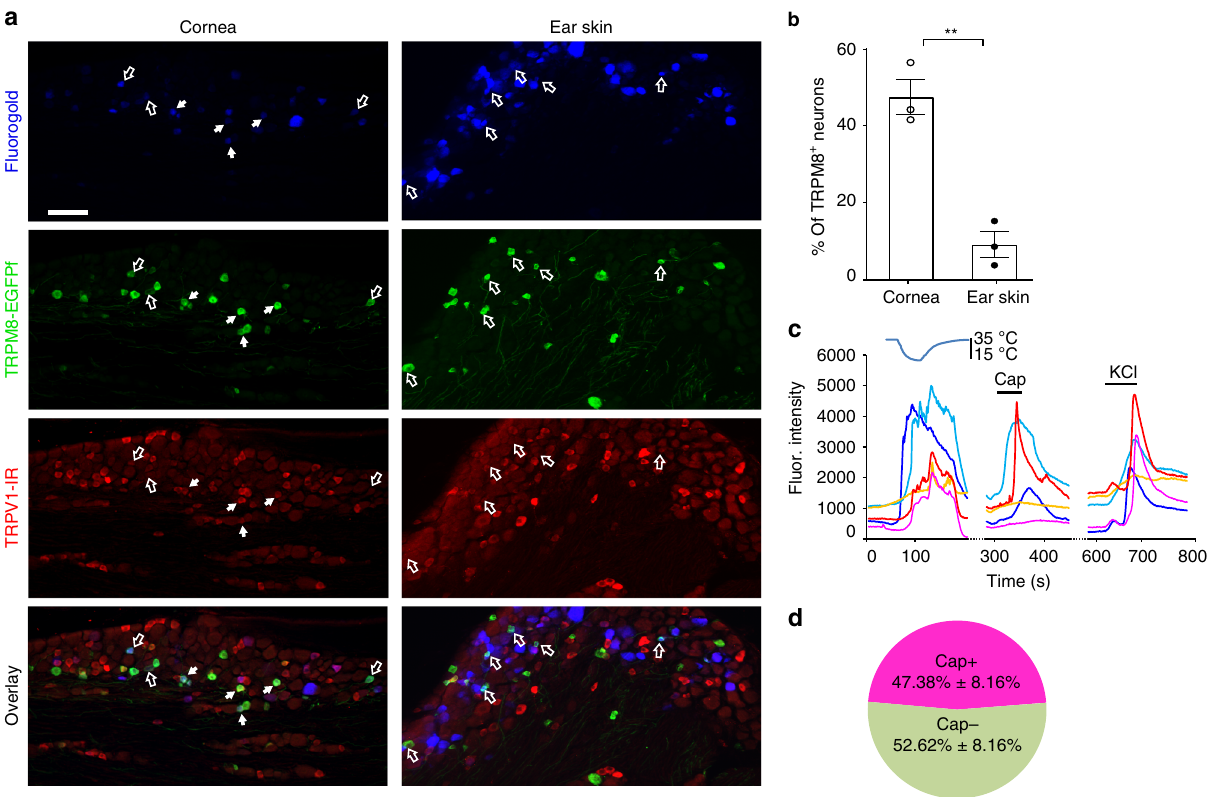
Fig. 2 TRPV1 is co-expressed with TRPM8 in corneal sensory neurons. a Representative images showing a higher overlap between TRPM8-EGFPf and TRPV1-immunoreactivity (IR) in cornea-projecting neurons (retrogradely labeled by fl uorogold from the cornea) than in skin-projecting neurons (retrogradely labeled by fl uorogold from the ear skin). White arrows indicate fl uorogold + /TRPM8 + /TRPV1 + neurons, whereas hollow arrows indicate fl uorogold + /TRPM8 + /TRPV1 − neurons. b Quanti fi cation of the co-expression of TRPV1 with TRPM8 in sensory neurons innervating the cornea and ear skin, respectively ( n = 3 mice/group). c Representative neuronal calcium responses to cold, capsaicin (10 µ M), and KCl (100 mM) within the cornea- projection area in the ophthalmic division of the trigeminal ganglion explants from Pirt GCaMP3/ + mice in which a calcium indicator GCaMP3 was expressed in primary sensory neurons. d Quanti fi cation of capsaicin responses in 56 cold-sensitive neurons located within the cornea-projection area of four trigeminal ganglia from three Pirt GCaMP3/ + mice. Cap: capsaicin. Data are expressed as mean ± s.e.m. Statistical analysis by two tailed Student ’ s t -test. ** P < 0.01. All images shown are representative of three independent experiments using tissues from at least three different mice. Scale bars in a 100 μ m. Source data are provided as a Source Data fi